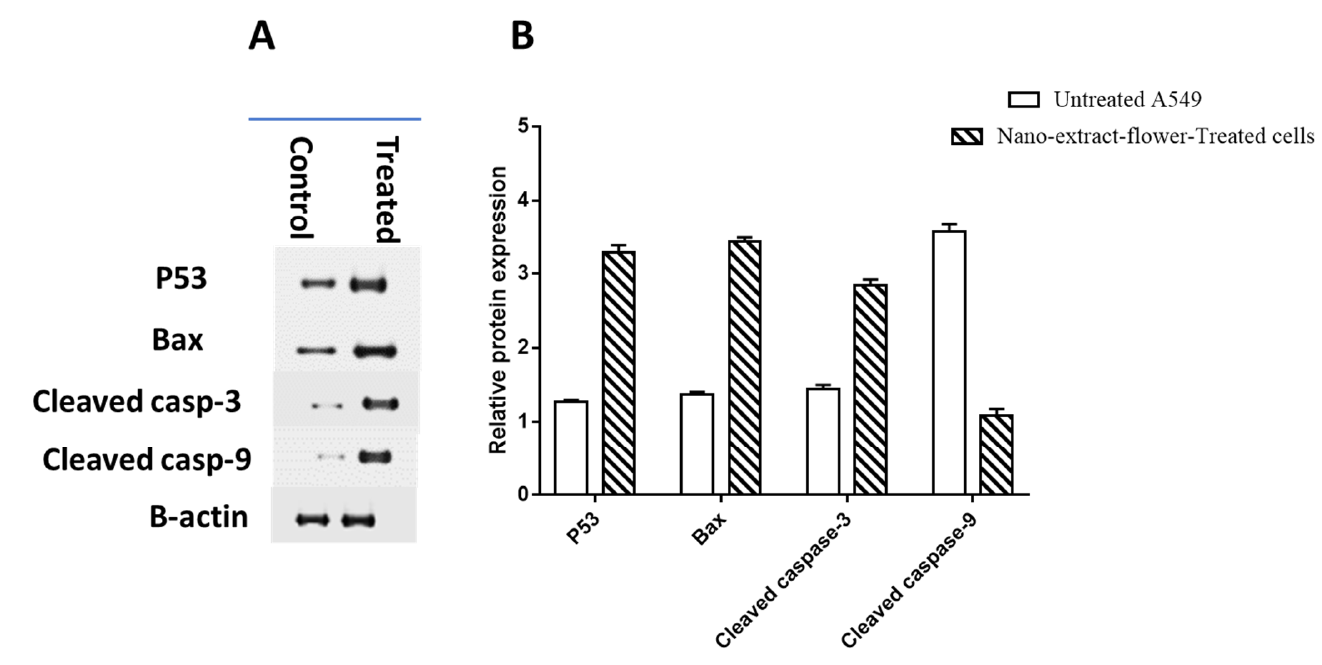
Figure 6. Protein expression level in the untreated and treated A549 cells with flower extract AgNPs (IC 50 = 1.52 μM, 48 h). ( A ) Gel images and ( B ) quantification of band width. Data normalization was made relative to β-actin.